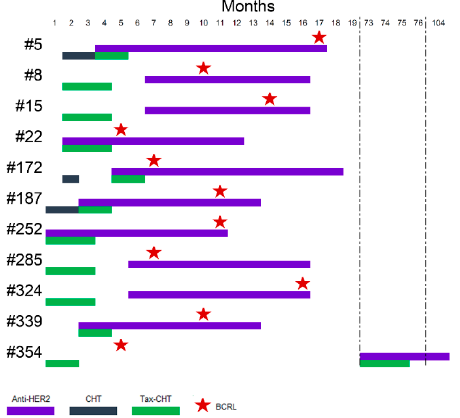
Figure 3. Schematic representation of the therapeutic history of BCRL patient. The timeline depicts the months after surgery, as reported on the top; patients are reported as rows, according to their ID on the left; the type of therapy is color-coded on the basis of the legend on the bottom. The first BCRL diagnosis is highlighted as a red star in the timeline. CHT, chemotherapy (no taxanes); Tax-CHT, taxane-based chemotherapy; BCRL, breast cancer related lymphedema.